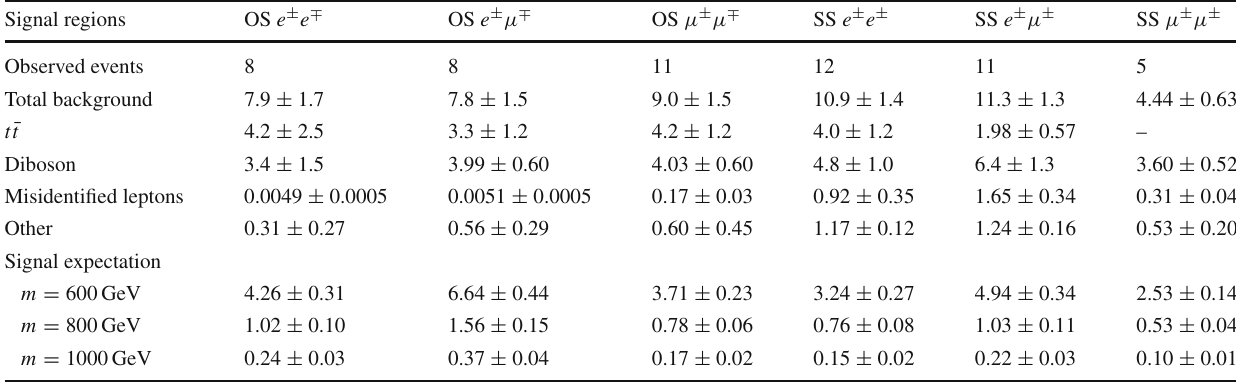
Table 3 The number of expected background events in signal regions after the likelihood fit, compared with the data. Uncertainties corre- spond to the total uncertainties in the predicted event yields and can be smallerthanthevalueofindividualcontributionssummedinquadrature because the latter can be anti-correlated. Due to rounding, the totals can